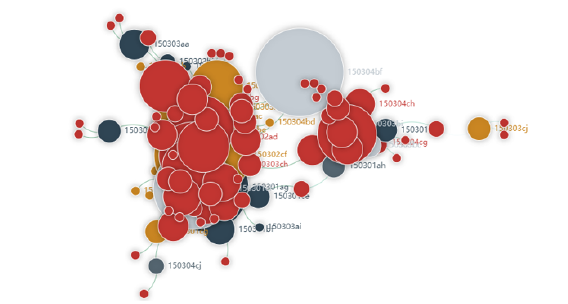
Figure 8. Center area of Figure 7; the students located here have rich social